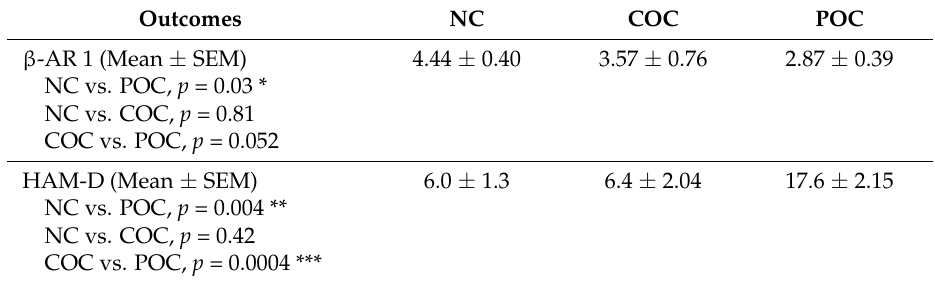
Table 3. Comparison of β -AR 1 protein levels (ng/mg) with independently obtained HAM-D score among women in the NC, COC, and POC